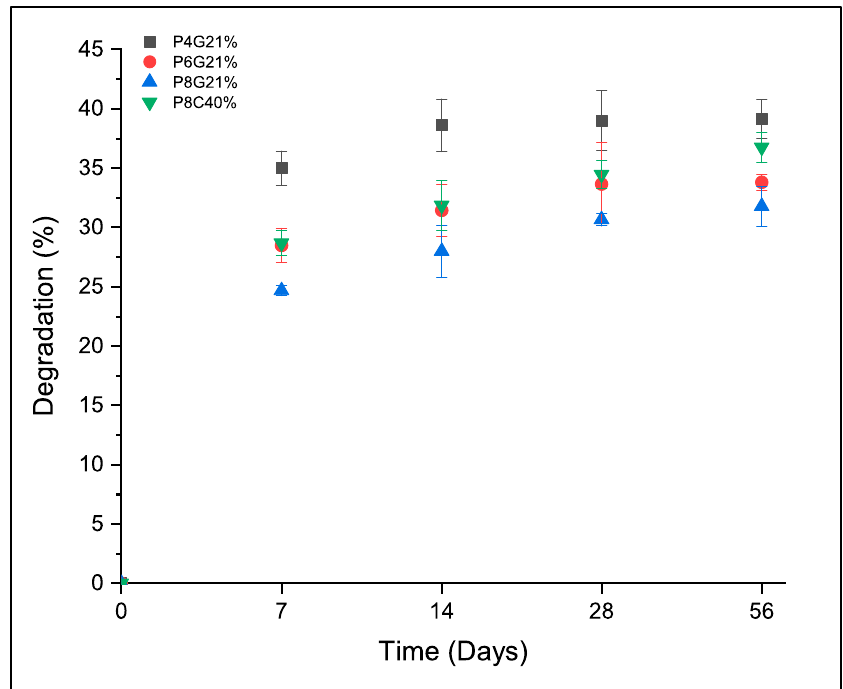
Figure 4. Degradation rate profile for different varieties of DN hydrogels with lysozyme.